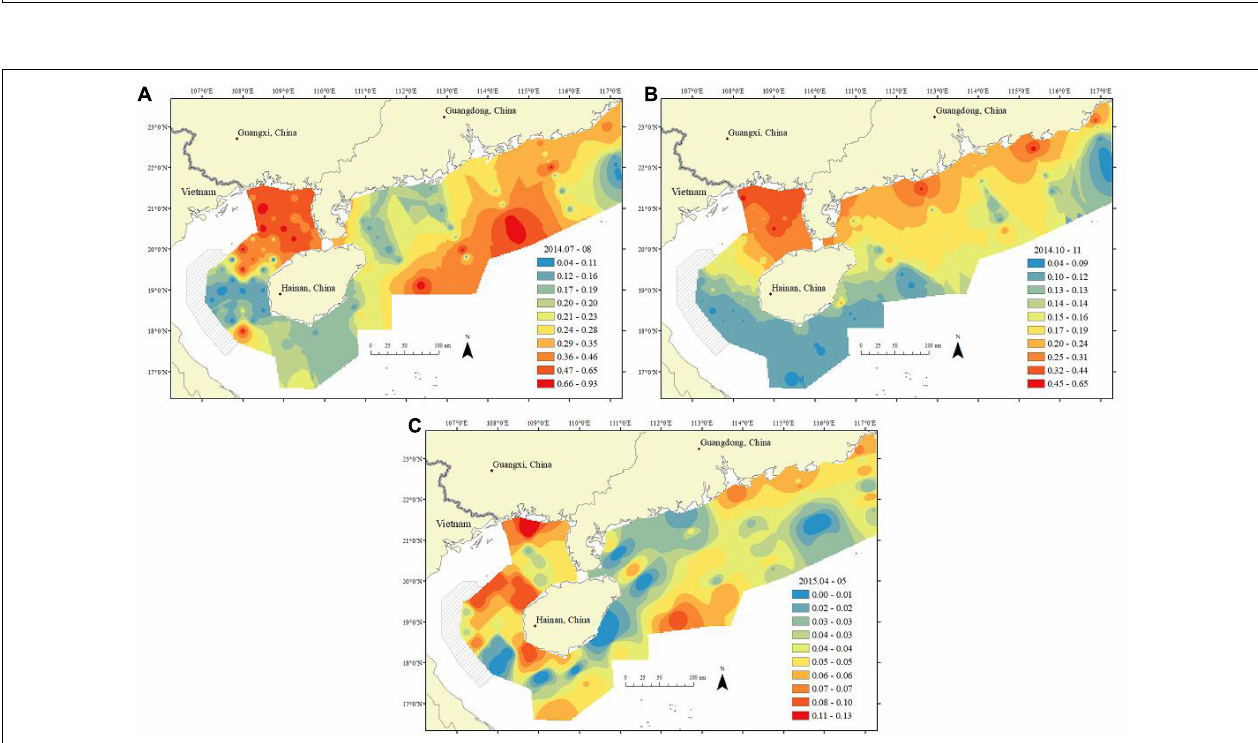
FIGURE 7 | The temporal and spatial distribution of Silicates at 20 m depth (Si20). Blue is the lowest, yellow is the middle, and red is the highest. (A) July to August 2014; (B) October to November 2014; (C) April to May 2015.